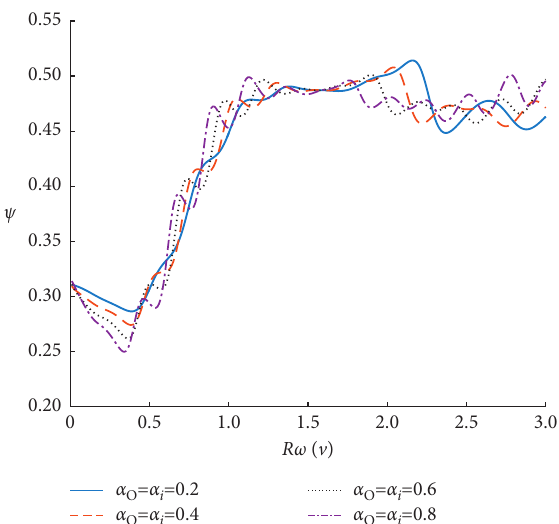
Figure 4: Curves of radial stress varying with frequency for dif- ferent models.